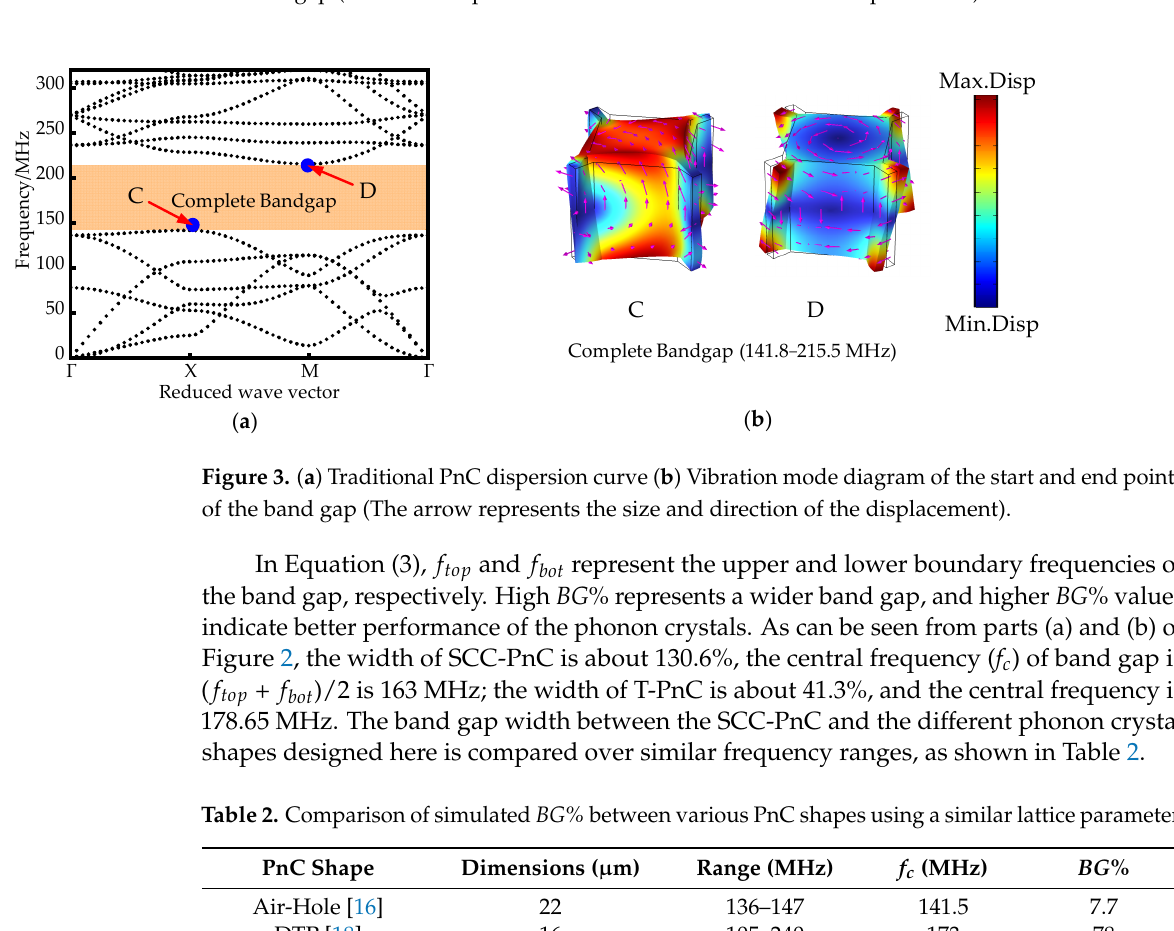
Figure 2. ( a ) SCC ‐ PnC dispersion curve ( b ) Vibration mode diagram at the start and end points of the band gap (The arrow represents the size and direction of the displacement).